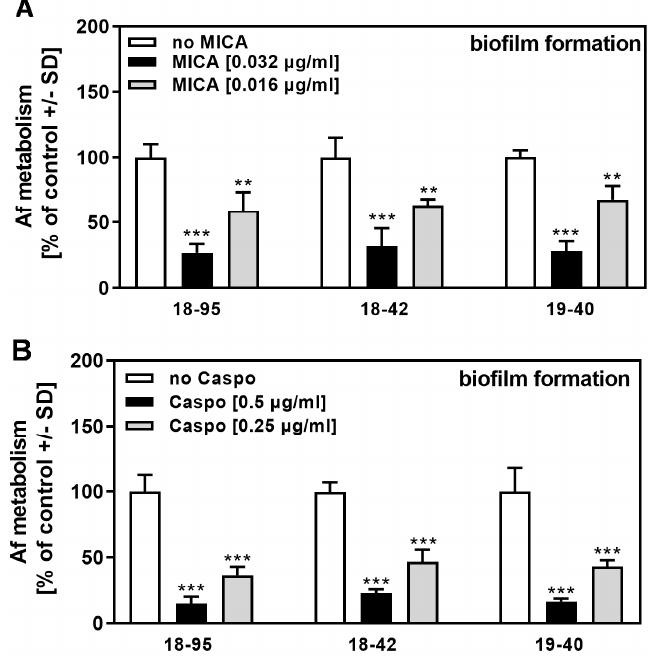
Figure 4. AfuPmV-1 infection does not sensitize A. fumigatus to MICA or CASPO. Infected (18–95, 19–40) or virus-free (18–42) Aspergillus- forming biofilm was incubated with ( A ) MICA (0.016 or 0.032 µg/mL) or ( B ) CASPO (0.25 or 0.5 µg/mL) at 37 °C for 16 h. Fungal metabolism was measured by XTT assay. Metabolism in the presence of RPMI alone (white bars for each strain) was regarded as 100%. Comparisons: No drug (white bars) vs. drug (black and grey bars) for each strain. Statistical analysis (n = 4): Unpaired t -test, two or three asterisks = p ≤ 0.01, or p ≤ 0.001, respectively. No significant differences in drug response were observed when comparing infected strains (18–95 and 19–40) to the virus-free strain (18–42).